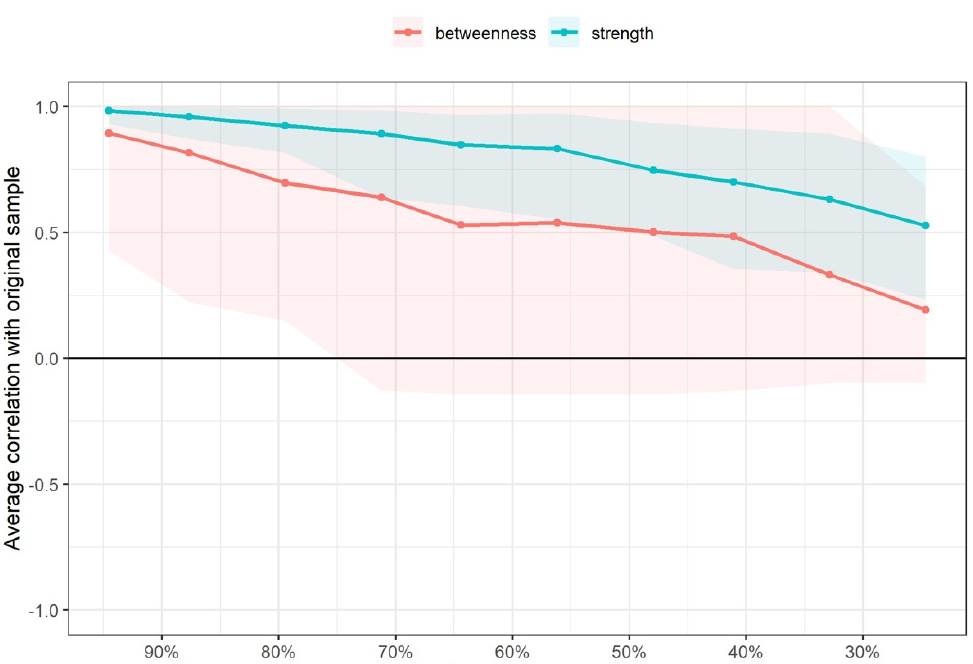
Figure 4. Average correlations between centrality indices of networks sampled with persons dropped and networks built on the entire input dataset, at all follow-up time points. Lines indicate the means and areas indicate the range from the 2.5th quantile to the 97.5th quantile.